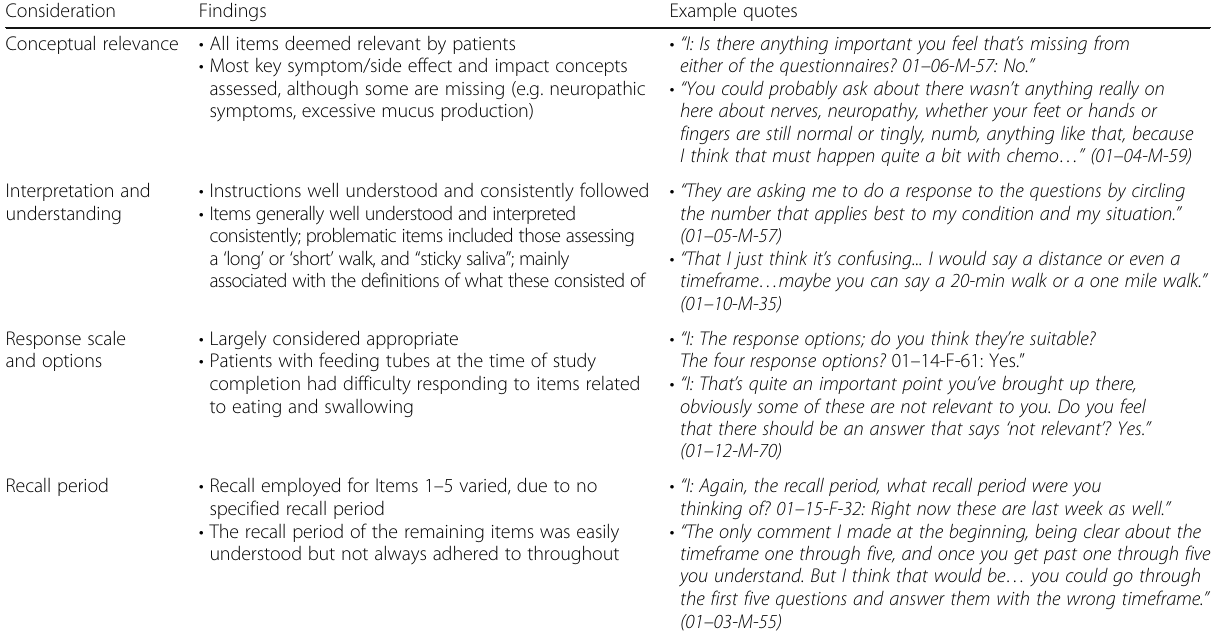
Table 5 Summary of cognitive debriefing findings Consideration